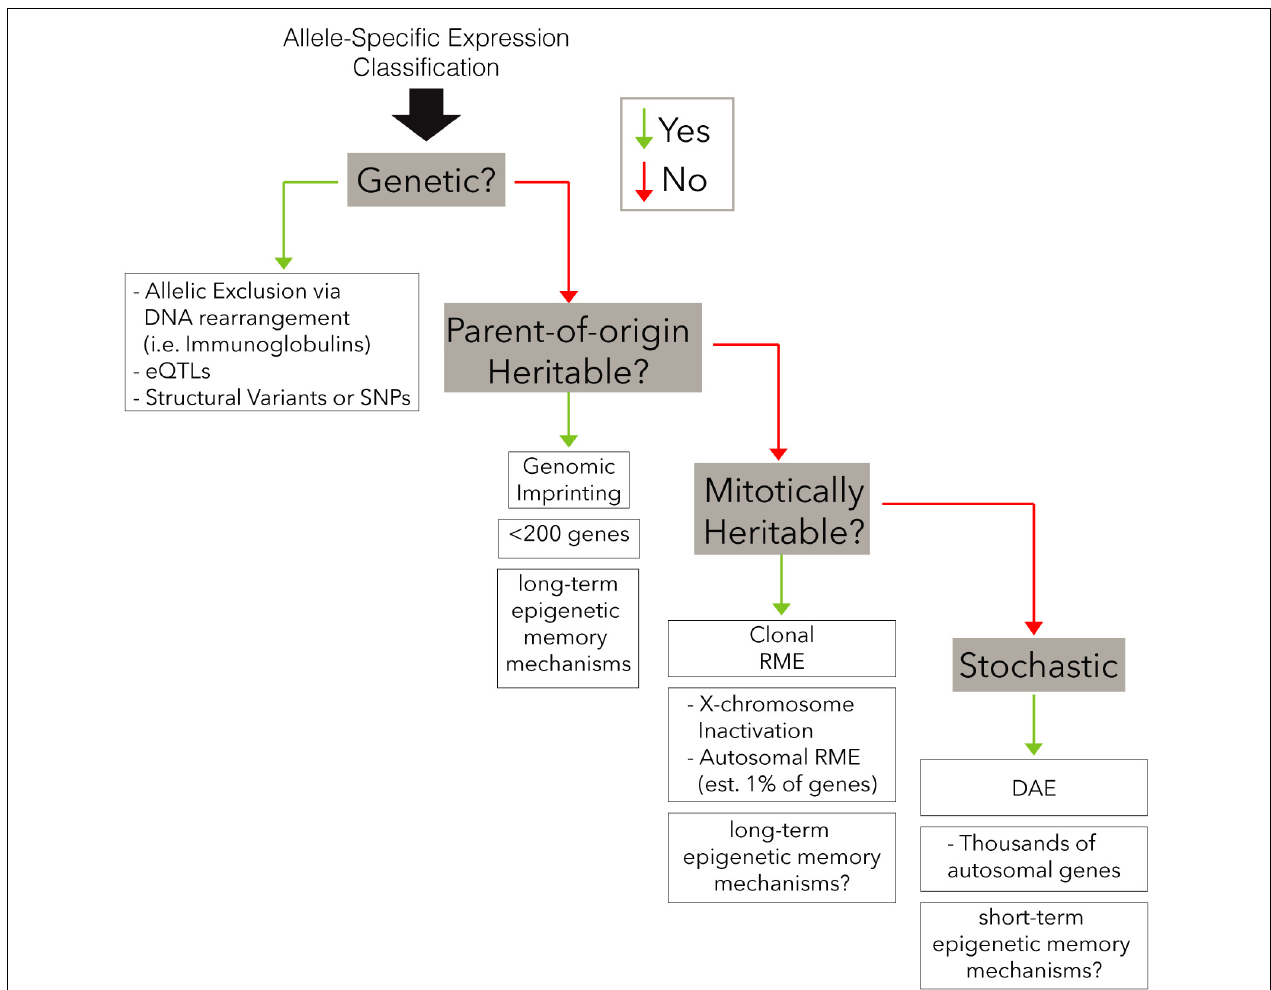
FIGURE 3 | A decision classification tree for different subtypes of allele-specific epigenetic and expression effects according to heritability, clonality and stability. The decision tree shows that different allele-specific expression effects arise according to genetic, genomic imprinting, clonal RME and stochastic DAE. Each of these increases cellular diversity and adaptability and are potential barriers to eliminating metastatic cancer in